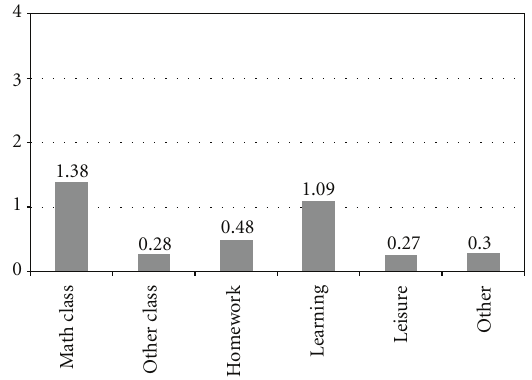
Figure 1: Average intensity of test-related